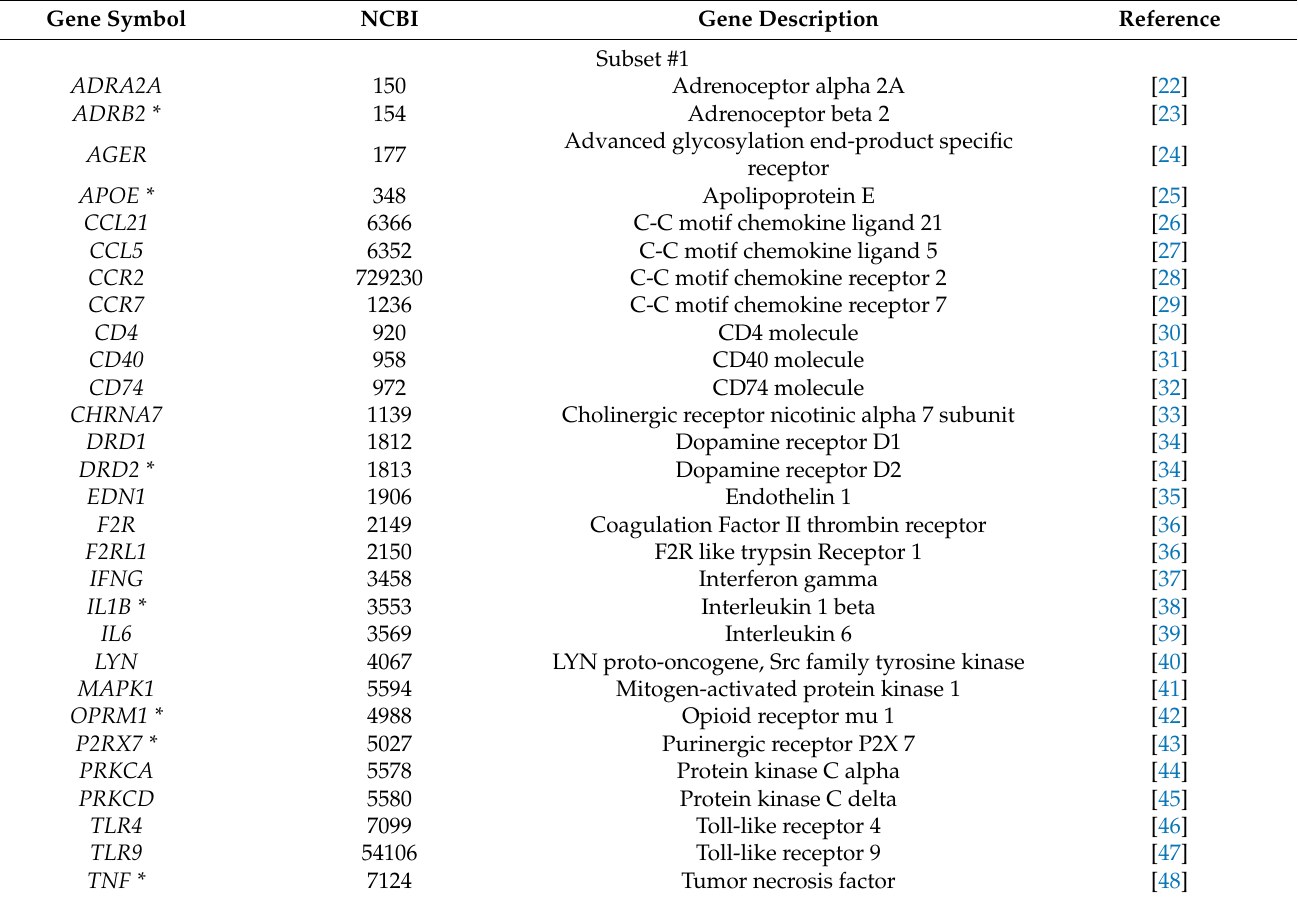
Table 1. Overview of the n = 72 genes contained in the proposed NGS panel. Subset 1 includes d = 29 genes identified using a computational functional genomics-based approach in which the gene sets are reduced to the most relevant items based on the importance of the gene within the polyhierarchy of biological processes characterizing the disease [17]. Subset 2 resulted from the intersection of two proposed sets of human genes involved in modulating the risk or clinical course of persistent pain “Mogil” [9], and “Zorina-Lichtenwalter”. Gene